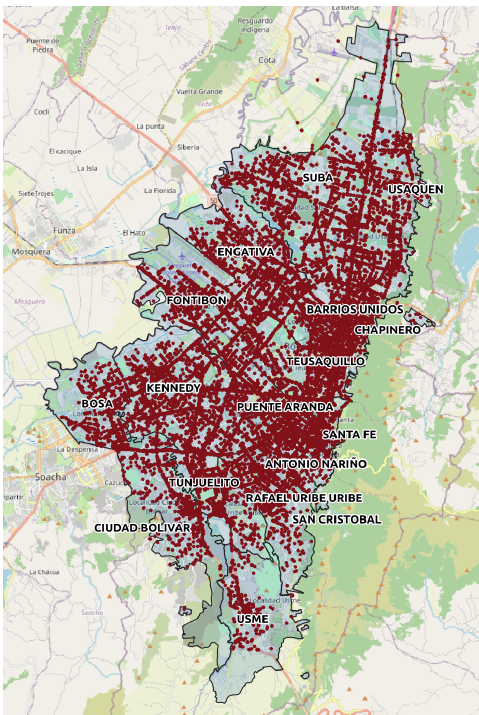
Figure 3. Location of traffic accidents that occurred from October 2018 to July